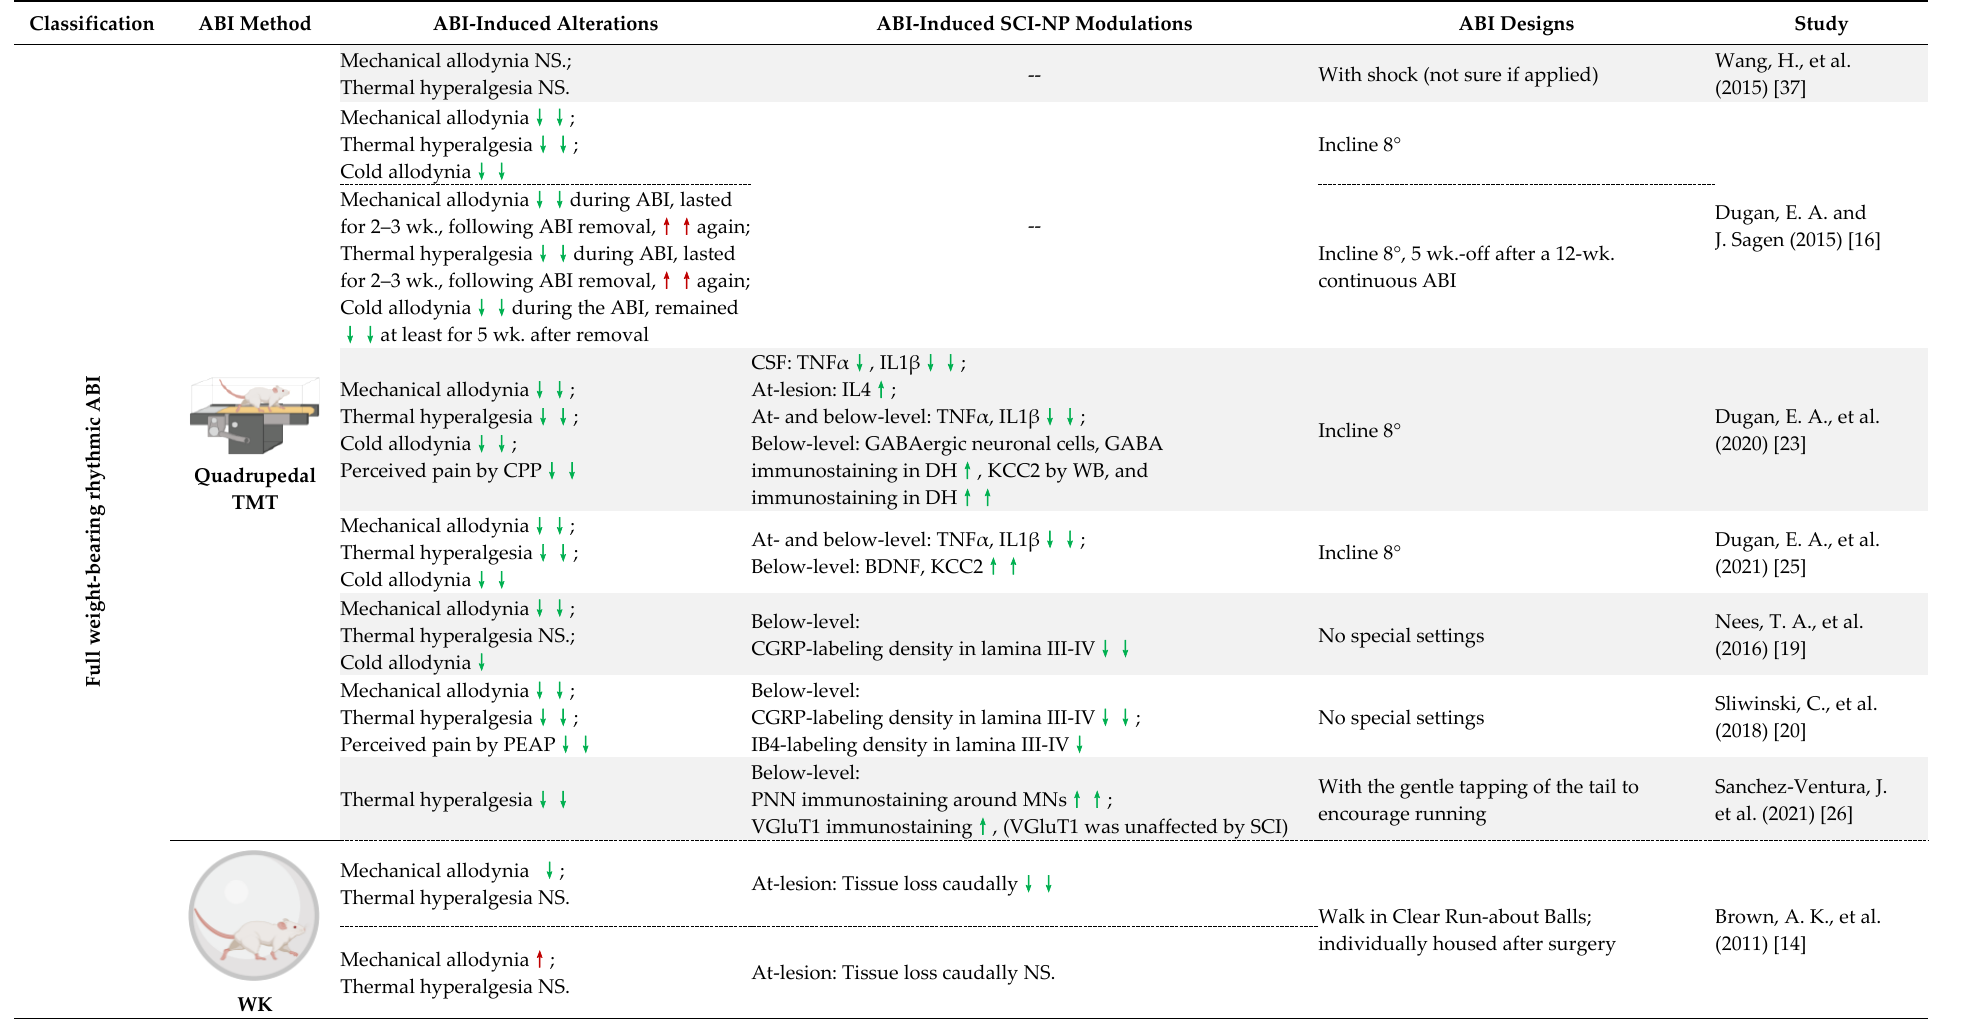
Table 3. Full-Weight Bearing vs. Non-Full Weight-Bearing Rhythmic ABI.